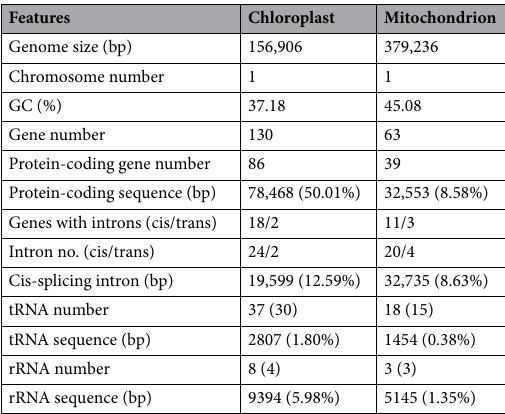
Table 2. The basic features of chloroplast and mitochondrial genomes in C. lanatus. The count excluding the gene duplicates. The note is applicable only to the numbers mentioned in brackets for features tRNA number and rRNA